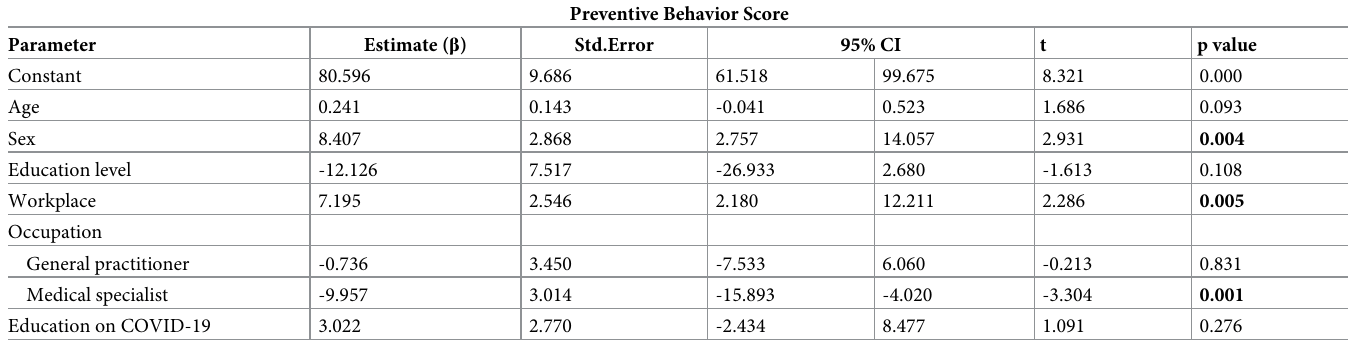
Table 5. Multiple regression analysis results of explanatory variables for the preventive behavior